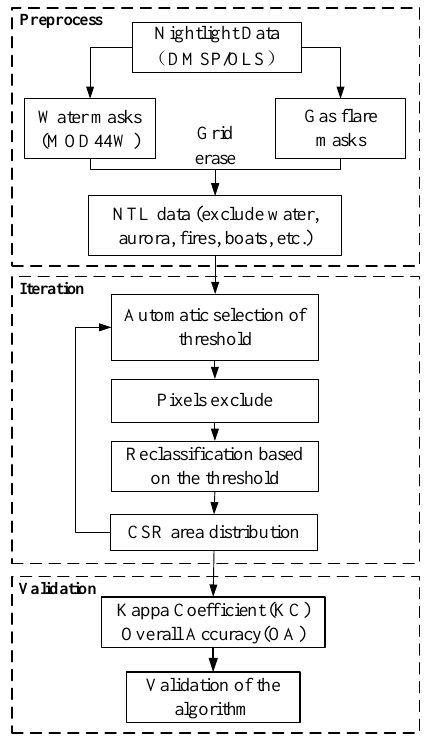
Figure 2. Flowchart of the proposed approach.